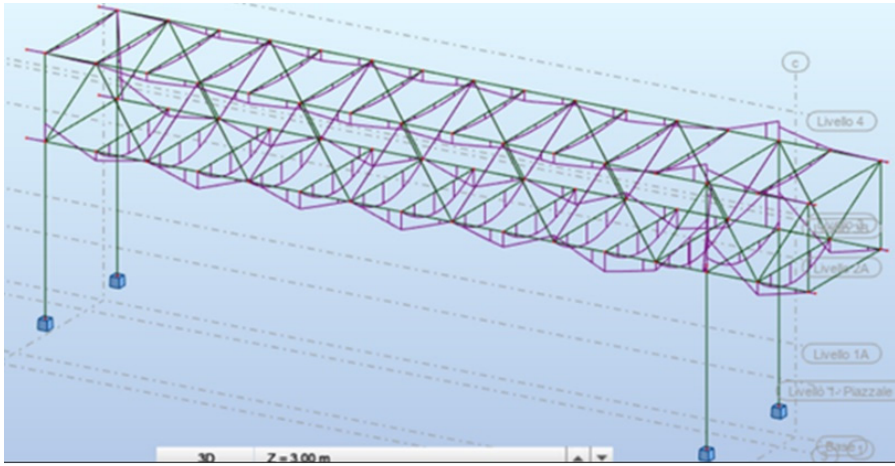
Figure 7. Analytical model of the reticular structure result (net of seismic actions).